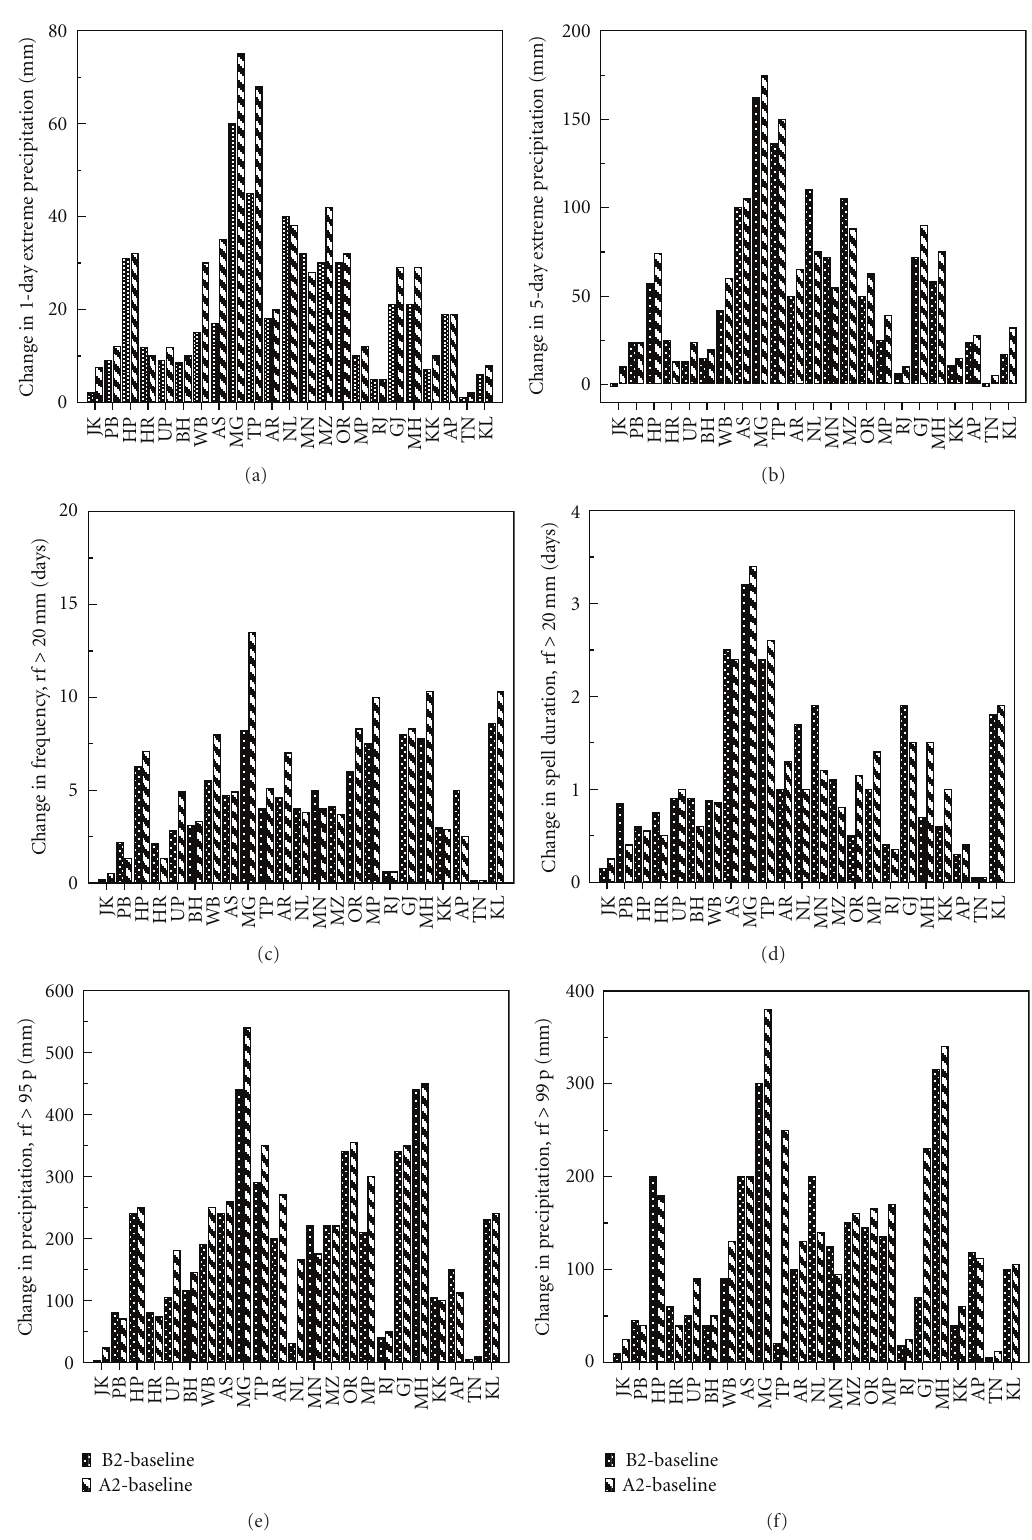
Figure 8: Statewise changes in one-day maximum precipitation (a) and five-day maximum precipitation (b); count of heavy rainfall days when rainfall exceeds 20mm (c) and spell duration of continuous heavy rainfall days (d) and heavy precipitation amount when rainfall exceeds 95th percentile, (e) and very heavy precipitation amount when rainfall exceeds 99th percentile (f) in A2 and B2 scenarios (2071– 2100) with respect to baseline